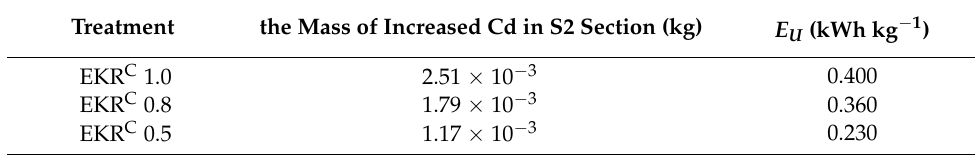
Table 3. The electrical energy consumption per unit mass ( E U ) for EKR C experiment. Treatment the Mass of Increased Cd in S2 Section